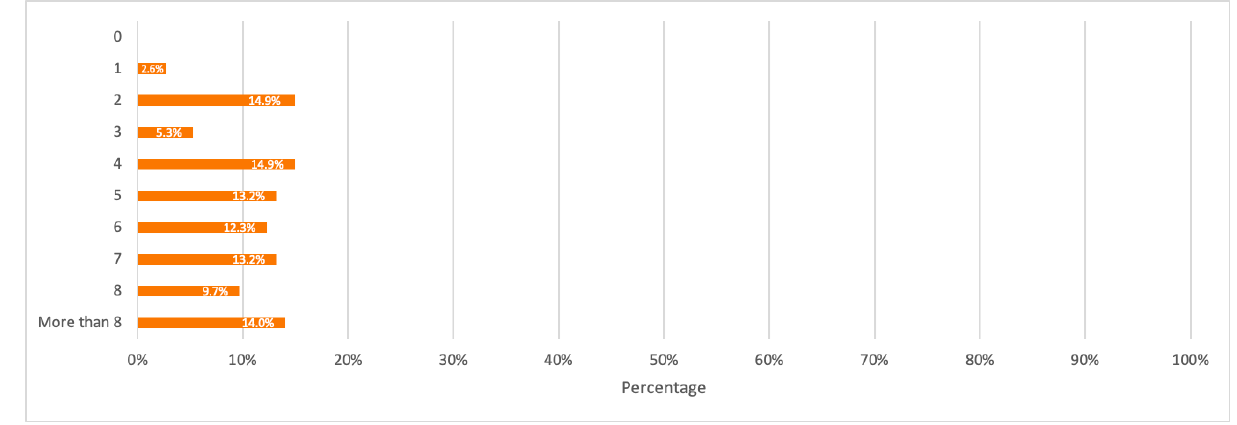
Figure 11. Number of mobile phones currently in-use by households.